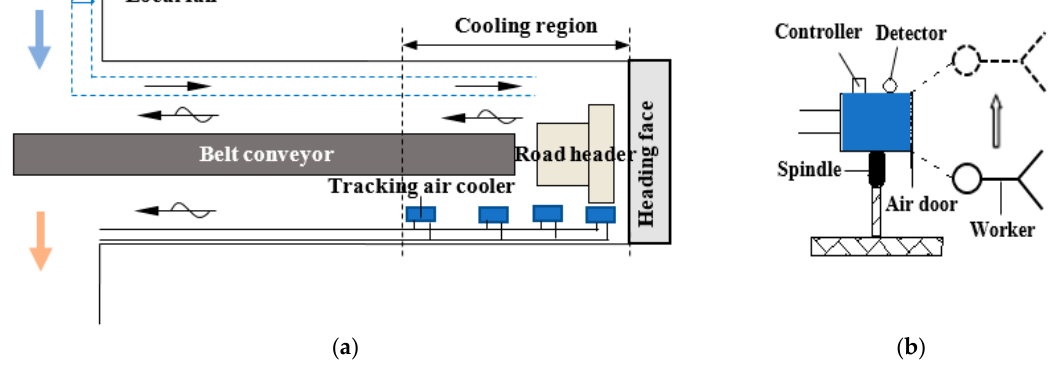
Figure 2. Schematic diagram of the new cooling strategy: ( a ) Layout mode of the tracking air cooler (top view) in the excavation roadway; ( b ) constitution of the tracking air cooler (side view).